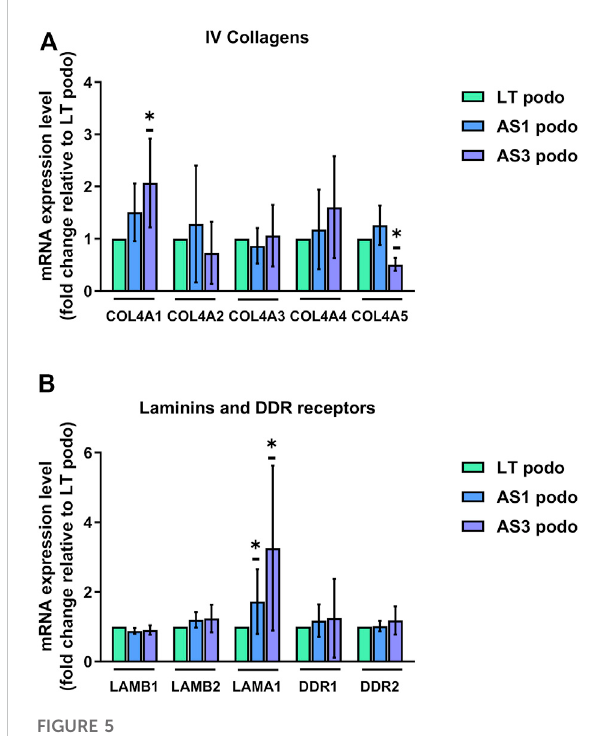
FIGURE 5 mRNA expression LT vs. Alport podocytes. In (A) , mRNA expression of COL4A1, COL4A2, COL4A3, COL4A4, and COL4A5 was analyzed using Q-PCR in Day 14 podocytes from the three cell lines and normalized to the expression level found in LT control podocytes for each experiment. (B) , relative mRNA expression of glomerularbasementmembranelamininsLAMB1,LAMB2,andLAMA1, andcollagenreceptorsDDR1andDDR2.Signi fi cancewastestedbyan unpaired t -test. Asterisk denotes statistically signi fi cant differences compared to LT control podocytes,* p < 0.05, n =